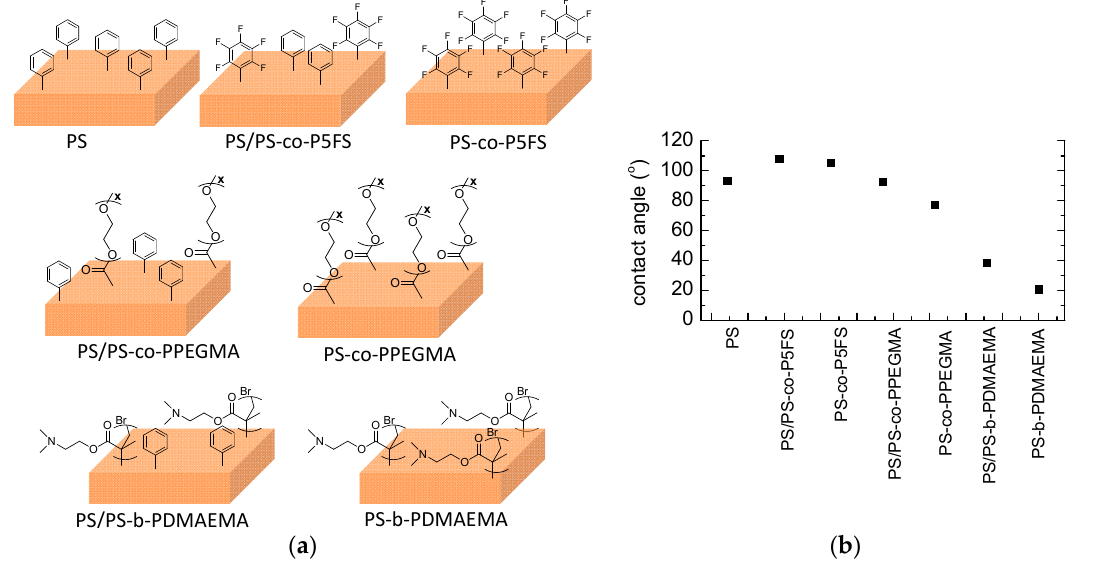
Figure 3. ( a ) Illustrative cartoon of the different surfaces explored prepared from either the pure polymers or blends; ( b ) Contact angle values of the surface prepared by spraying using polymer concentrations of 5 mg/mL and coating 10 layers.